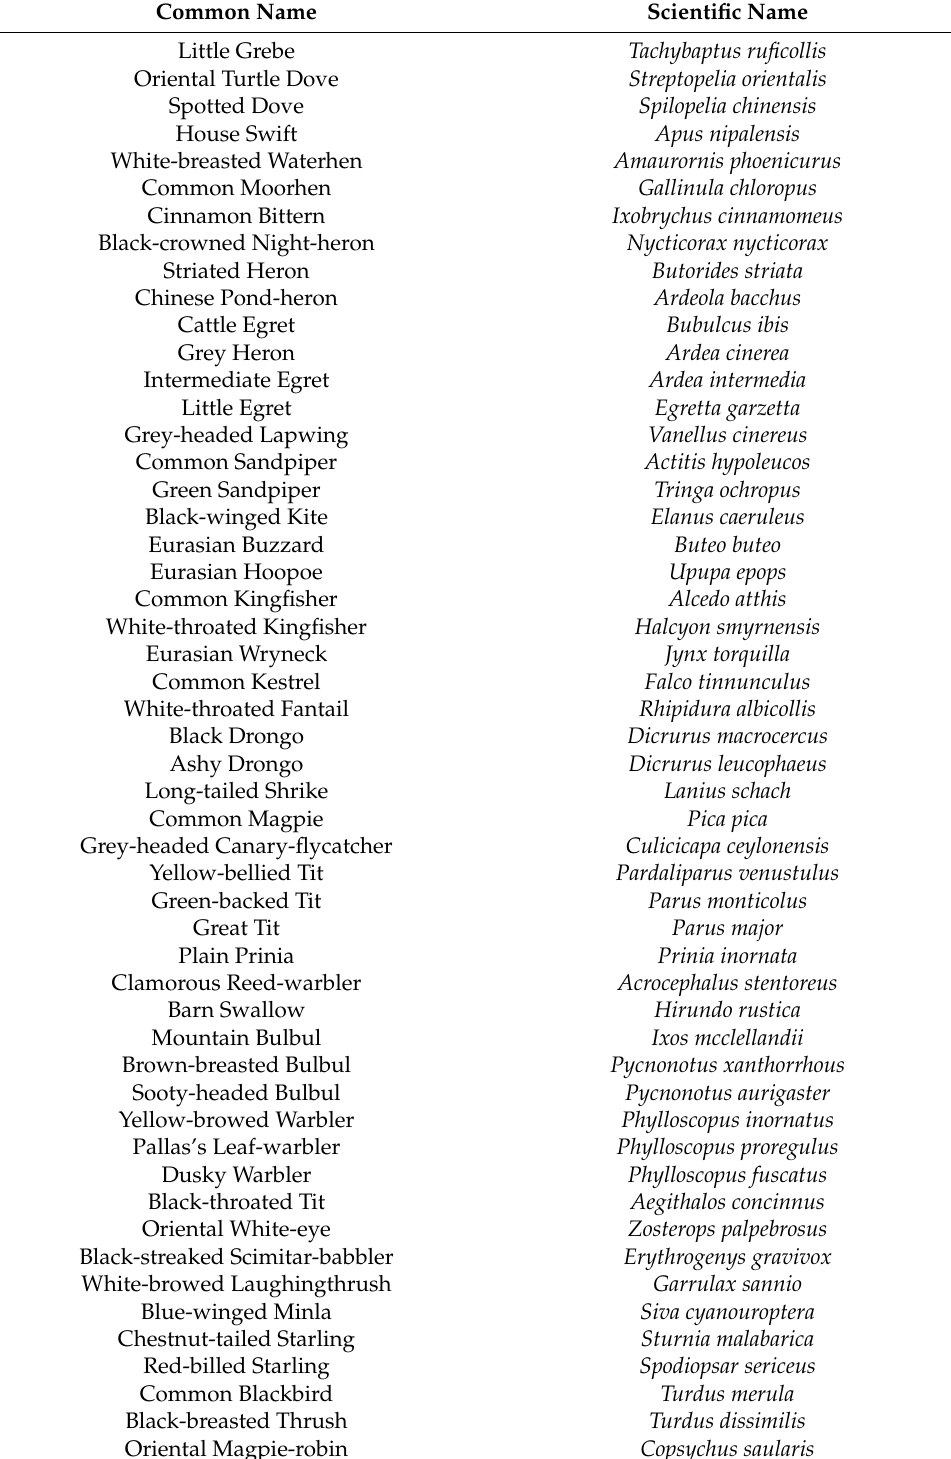
Table A1. List of bird species observed in three rivers in Kunming, Yunnan Province, China, during an annual cycle (spring and winter